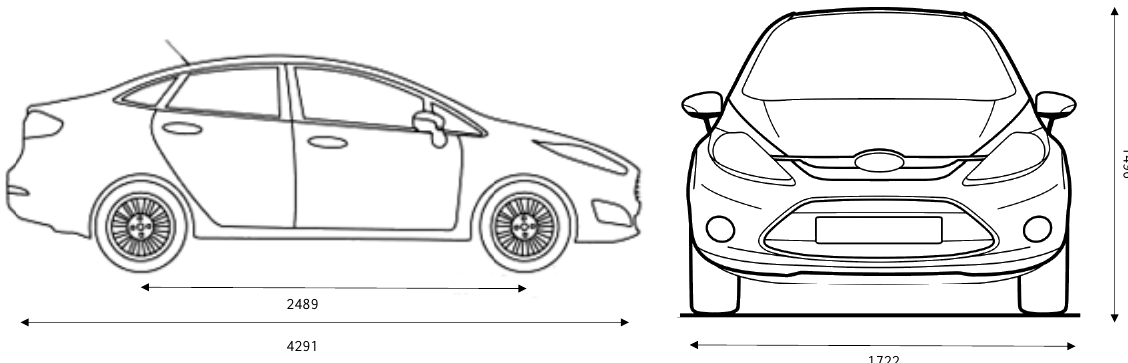
Figure 1. Schematic of a 2010 Ford Fiesta saloon (dimensions are in mm)